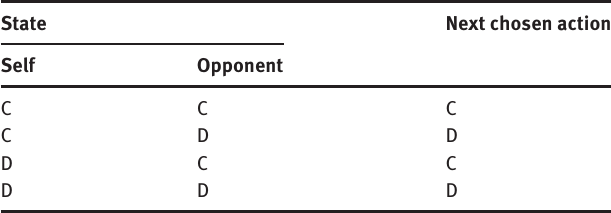
Table 2: The Tit-for-Tat Strategy as a Function of the State, Where Each State Consists of the Actions Chosen in the Previous Time